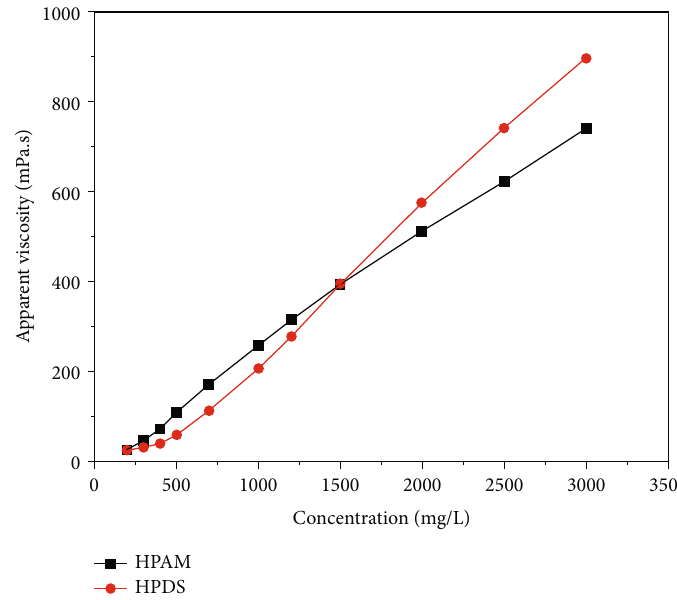
Figure 7: Relationship between apparent viscosity and concentration.